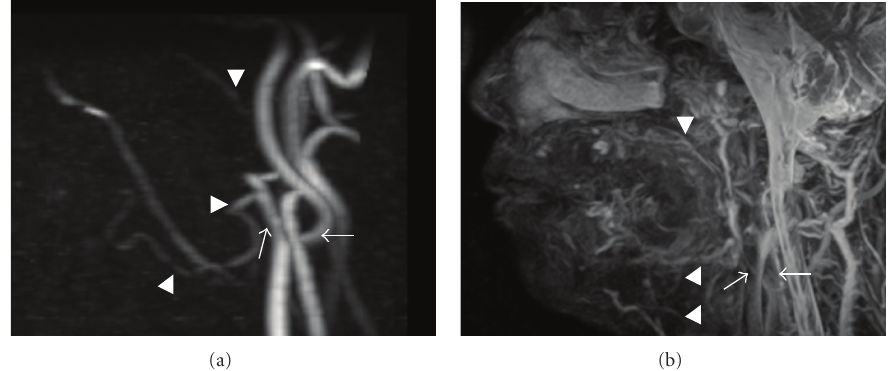
Figure 3: MRA using 3D-PC (a) and 3D-FBI (b) in the oral and maxillofacial regions of a healthy 48-year-old volunteer. MRA using 3D-FBI provides better 3D visualization of the vasculature of thin blood vessels, including the lingual and facial arteries, than 3D-PC-MRA. (a) On MRA using 3D-PC, the external (arrow) and internal carotid (black arrow), maxillary (arrowhead), and facial arteries (black arrowhead) are shown. Acquisition time was 10 minutes and 15 seconds. (b) On MRA using 3D-FBI, the external (arrow) and internal carotid (black arrow) and other peripheral vessels are shown. The maxillary (arrowhead), facial (black arrowhead), lingual (gray arrowhead), and further peripheral arteries are more precisely shown than in Figure 3(a) in the same subject. Acquisition time was 4 minutes and 5 seconds.